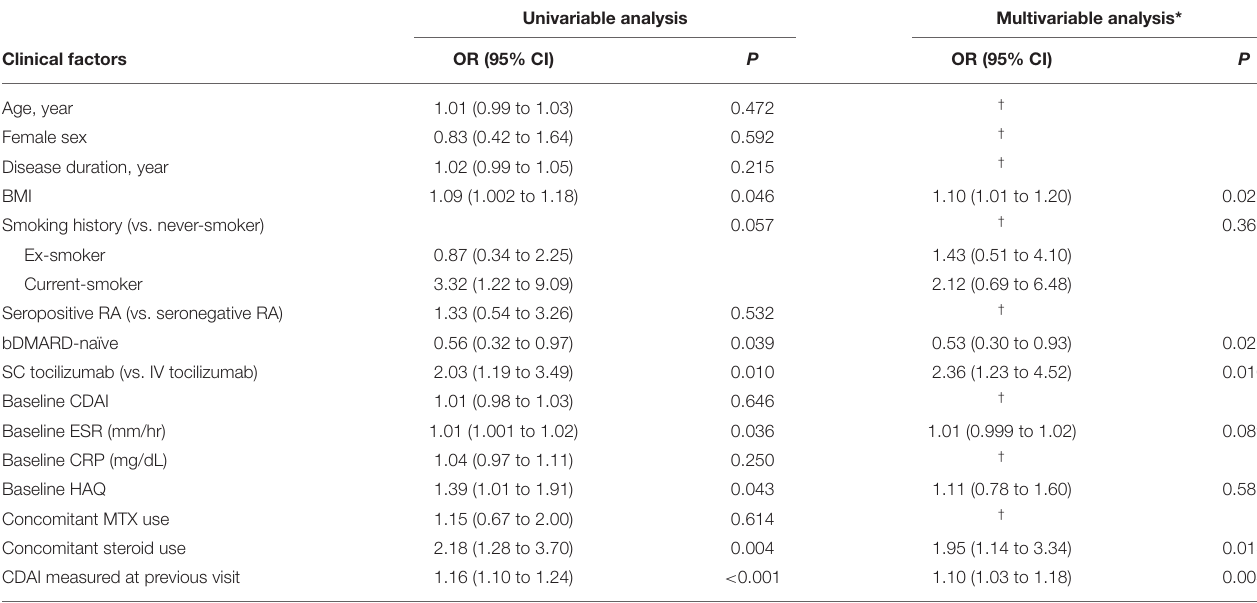
TABLE 2 | Clinical factors associated with the loss of CDAI-low disease activity (LDA).